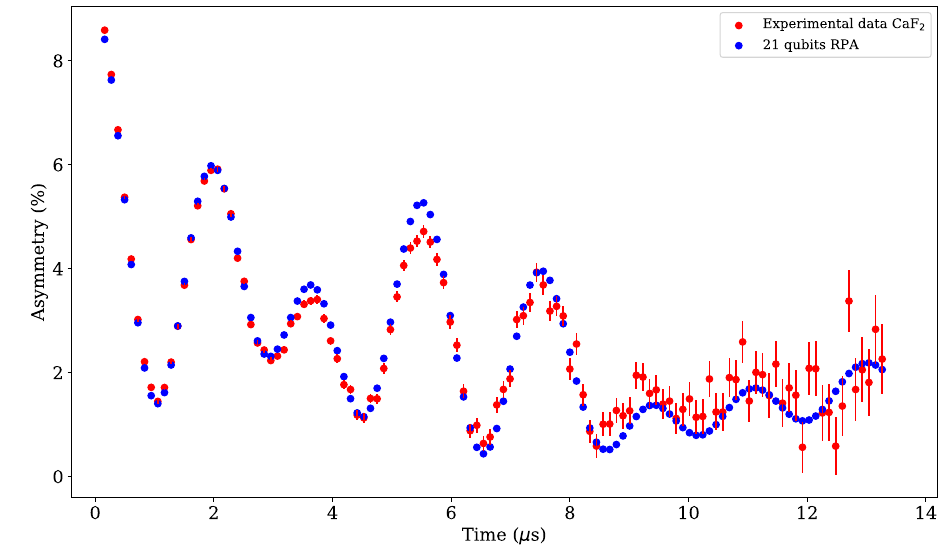
FIG. 16. The CaF 2 + μ + geometry is fixed in this simulation, and given by the density-functional-theory results of Ref. [9]. The nearest-neighbor fluorines are moved towards the muon by 0.19 Å, and the next-nearest-neighbor fluorines are moved towards the muon by 0.027 Å. The NNNN fluorines are at their equilibrium positions. We use a 21-qubit simulation with the random-phase- approximation method (with 48 samples per data point, and 40 second-order Trotter steps) to generate a polarization function for this geometry, P ( t ) . This polarization function is fitted to the experimental asymmetry data obtained in Ref. [9], using A ( t ) = A 0 P ( t ) + A bg , where A 0 and A bg are fitting parameters. The fit is performed using the Levenberg-Marquardt algorithm to minimize the normalized square residuals. The reduced χ 2 value of the generated data is